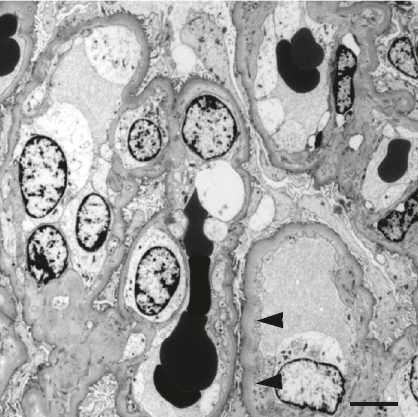
Figure 3: Electron micrograph of a glomerulus. Swollen glomerular endothelial cells with loss of fenestrations, irregularity thickened lamina rara interna with small remnants in the subendothelial spaces (arrowheads), and partial foot process effacement are seen. Bar=5.0 𝜇